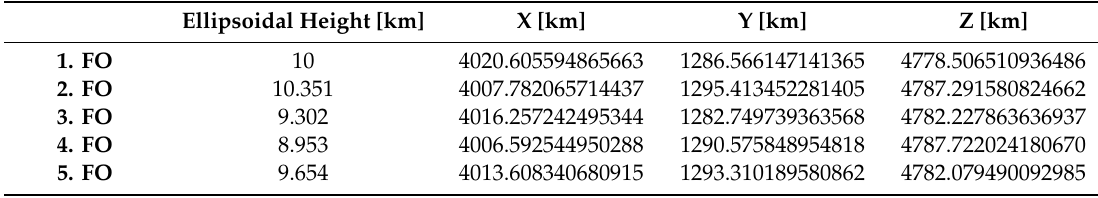
Table 1. The initial coordinates of flying objects acquired from the